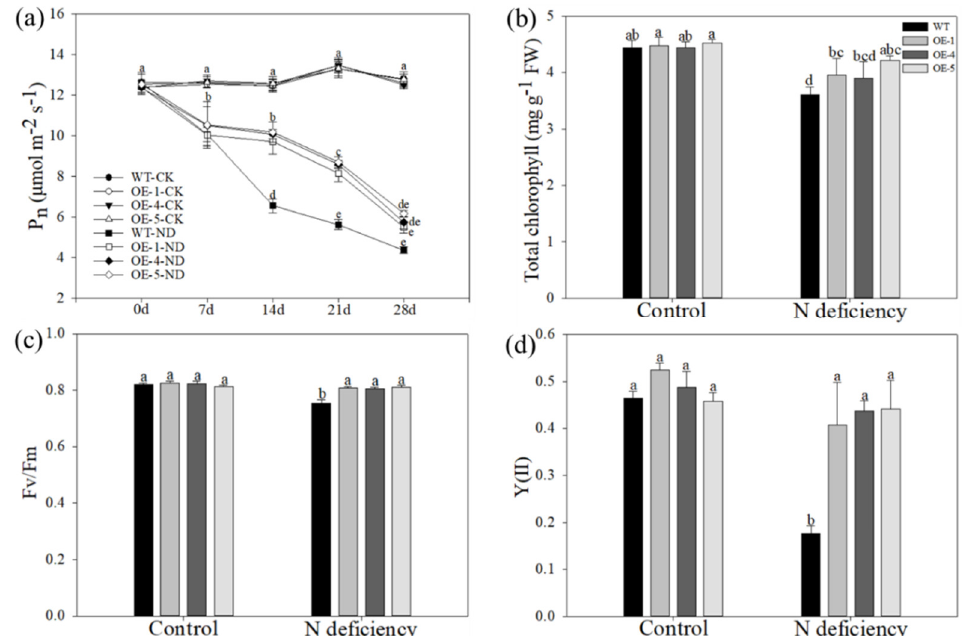
Figure 3. Overexpression of MdATG10 leads to higher photosynthetic capacity in apple under nitrogen-deficiency stress. ( a ) Changes in the net photosynthesis rate (Pn) were determined every seven days during the treatment. ( b ) Total chlorophyll, ( c ) Fv/Fm , and ( d ) Y(II) of WT and transgenic plants with or without treatment. Data are shown as the means of three replicates with SEs. Different letters indicate significant differences between treatments, according to one-way ANOVA followed by Tukey’s multiple range test ( p < 0.05).